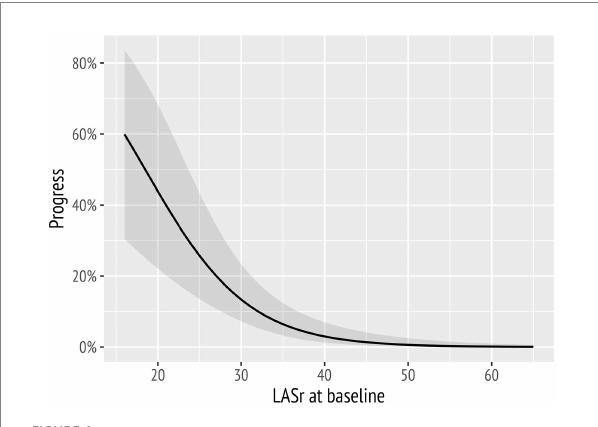
FIGURE 4 Probability of diastolic function worsening over time markedly increased with decreasing baseline left atrial reservoir strain (LASr)